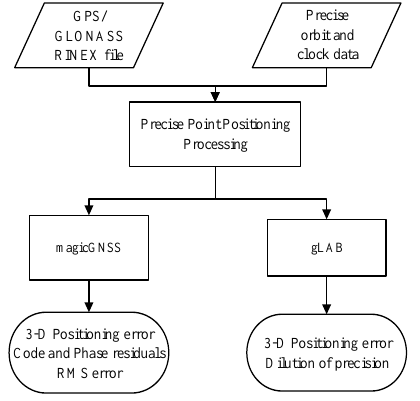
Figure 4: Positioning errors for combined (GR) observation processed by gLAB